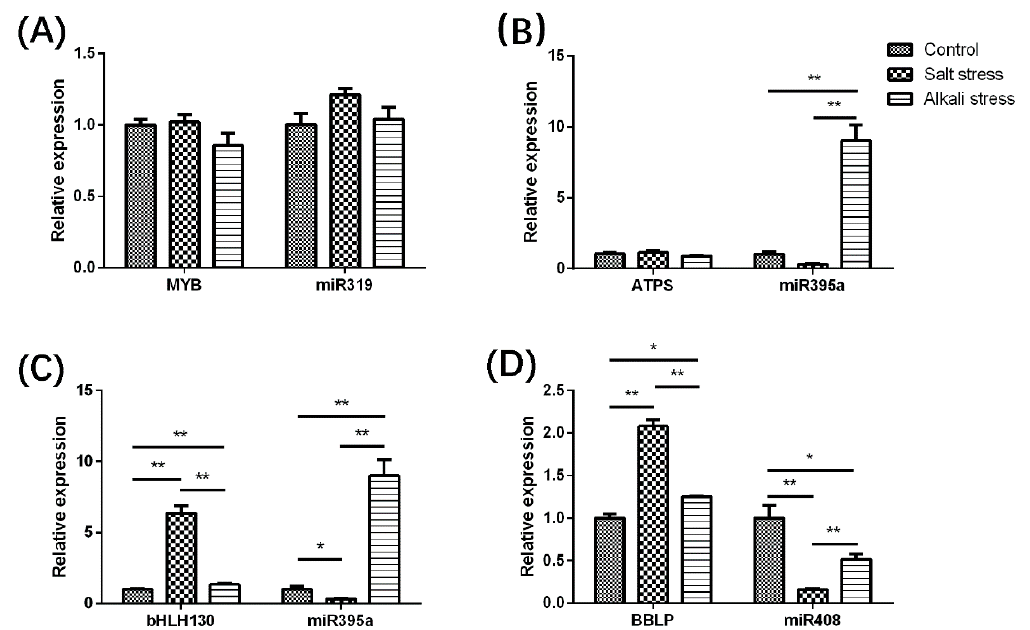
Figure 8. The expressions of 4 miRNA putative targets in R108 after treated with salt and alkali stress. The target genes expression identified with RT-qPCR in the left versus the sRNA-SEQ results of corresponding miRNAs in the right, ( A ) miR319-MYB; ( B , C ) miR395-ATPS and –Bhlh130; ( D ) miR408-BBLP. *: p < 0.05, **: p < 0.01.